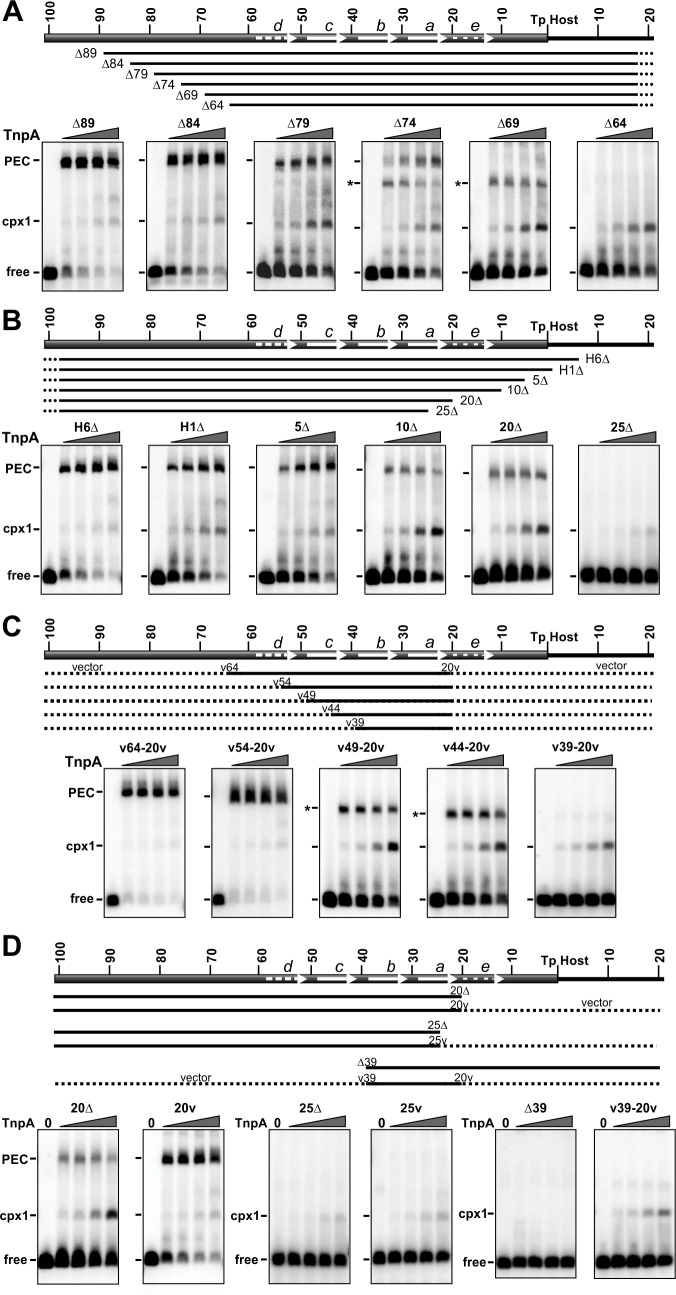
Gel mobility shift assays on IS1535 LE resections.(A) Deletion series of LE sequences from the transposon side. All probes contain 102 bp of DNA on the host end. Representations of the truncated LE probes are given below the schematic of the LE. H indicates host sequence, and dashes indicate appended vector sequence. EMSAs were performed with 1 to 128 nM TnpAIS1535 in 2-fold increasing concentrations. The position of the free probe, complex 1, and PECs are marked; the asterisks denote faster migrating PECs, which were confirmed for LEΔ69 to contain two DNA duplexes by the method used in Figure 3F. (B) Deletion series from the host side. All probes contain 149 bp on the transposon side with DNA endpoints on the right side as labeled. (C) Truncated LE segments embedded in vector DNA. Each probe has LE sequences beginning at nt 20 and varying amounts of upstream transposon sequence, as designated, with vector sequence (dotted lines) appended to each end. LE(v44-20v) PECs were confirmed to contain two DNA duplexes. (D) PEC formation by deleted LE probes without or with appended non-specific (vector) DNA. Shown are deletions ending in LE-20 and LE-25 at the border of motif a, and LE-39 on the border of motif b, without and with vector DNA appended to the deletion end points.